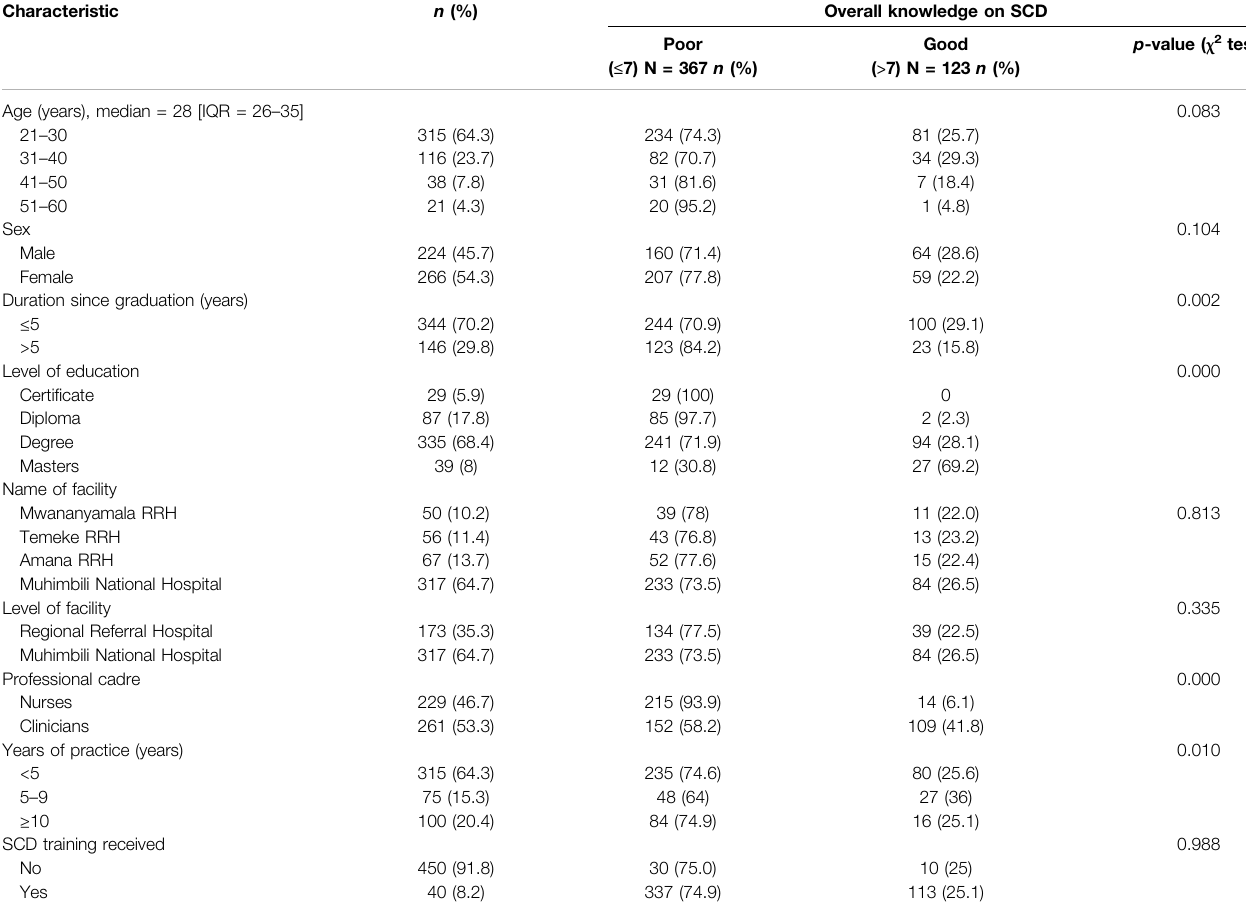
TABLE 1 | Socio-demographic characteristics and overall level of knowledge on SCD among healthcare workers in Dar es Salaam (N = 490)